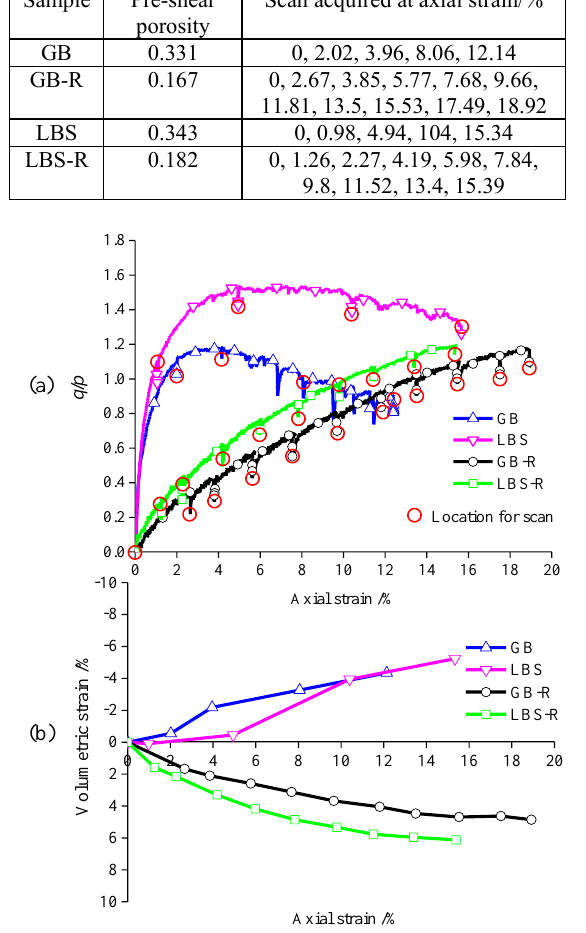
Fig. 1 Stress-strain curves: (a) stress ratio v.s. axial strain; (b) volumetric strain v.s. axial